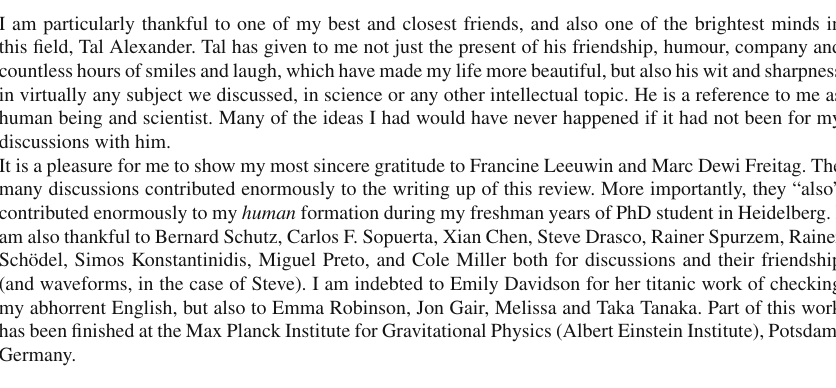
fig. cindÝnoub£ ϑ ra , EUR. Cycl. 352, les approches (litt. les degrés d’un danger)//